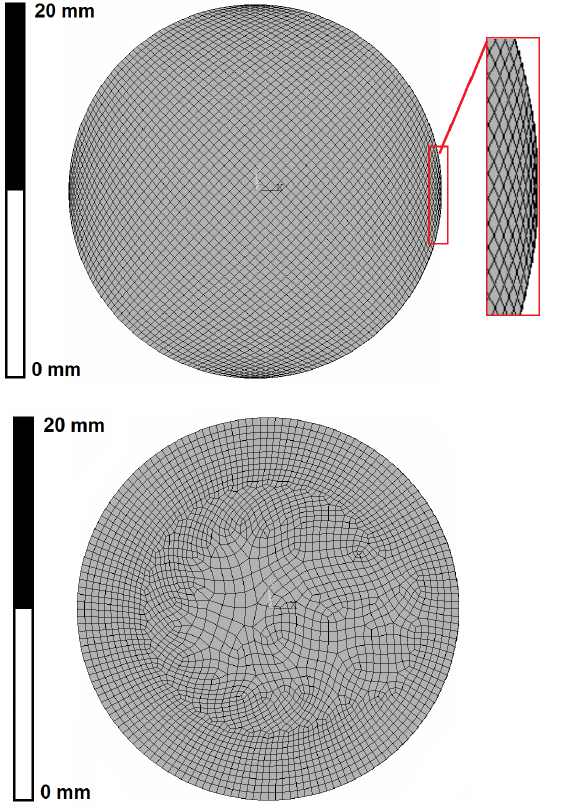
Figure 5. Outcome of the direct (top) and the sweep- ing method (bottom).